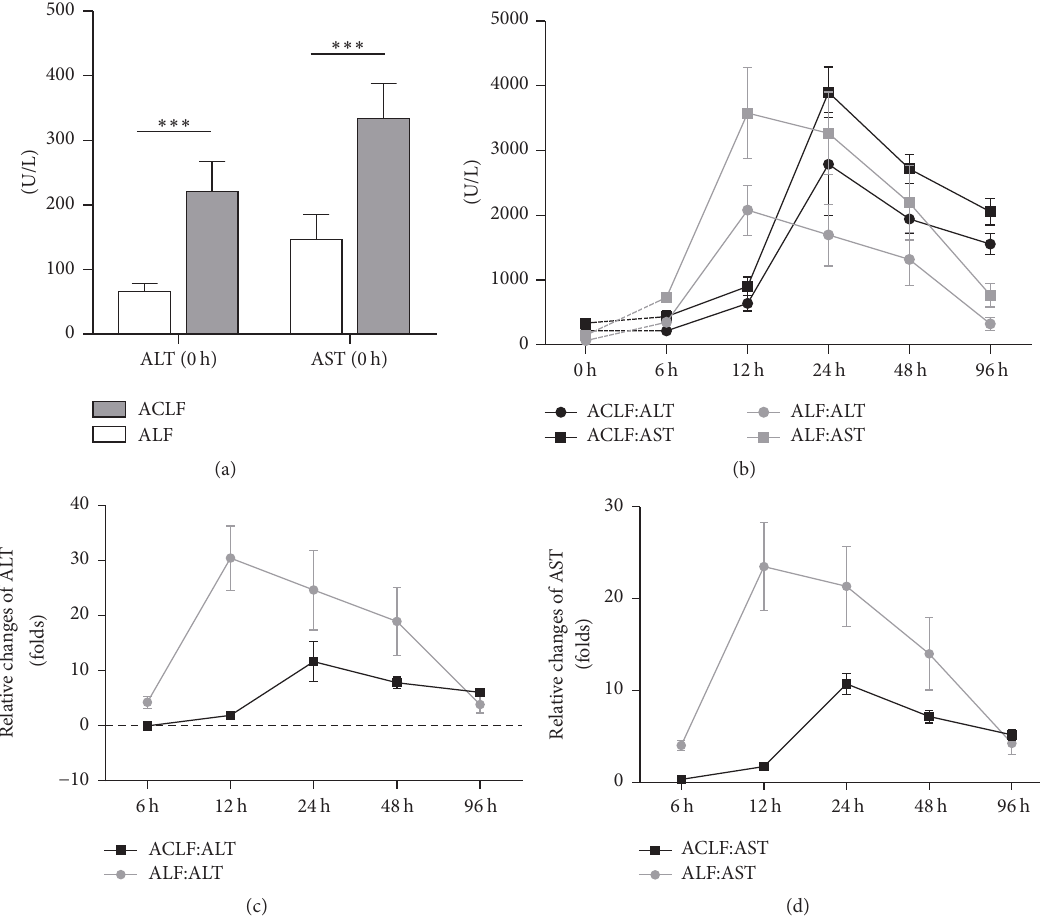
Figure 3: Serum ALT and AST levels. (a) The levels of ALT and AST at 0-hour point in ACLF group and ALF group; results were shown as means ± SD, ∗∗∗ 𝑝 < 0.001 . (b) The dynamic changes of ALT and AST in ACLF group and ALF group. (c, d) The relative changes of ALT and AST levels (ALT: alanine aminotransferase; AST: aspartate aminotransferase).